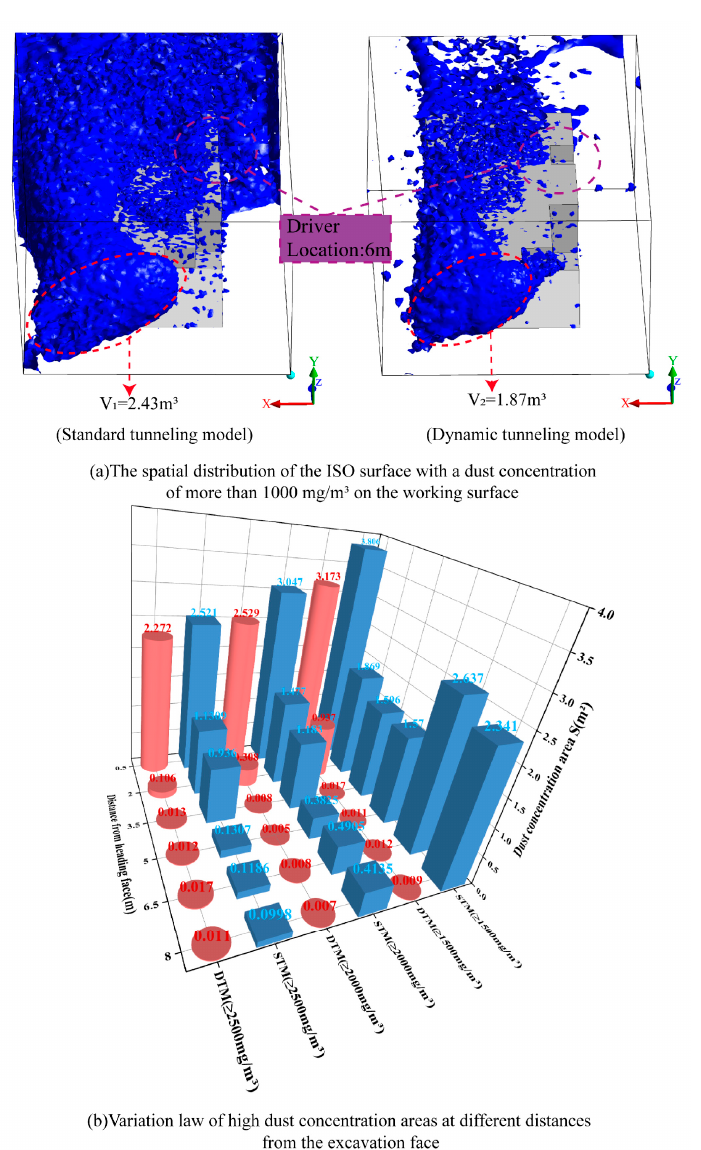
Figure 18. Variation rule of high dust concentration area in fully mechanized excavation face.